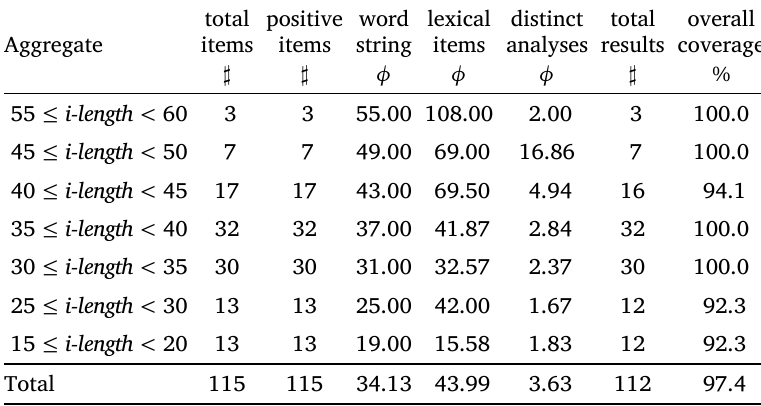
[incr tsdb()] coverage profile of ERG test items parsed by ERG and gesture